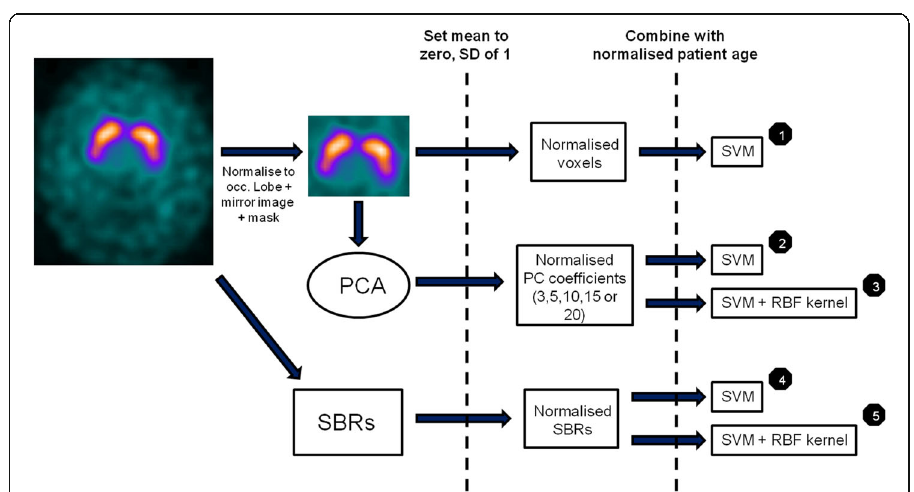
Fig. 1 Summary of the machine learning pipelines